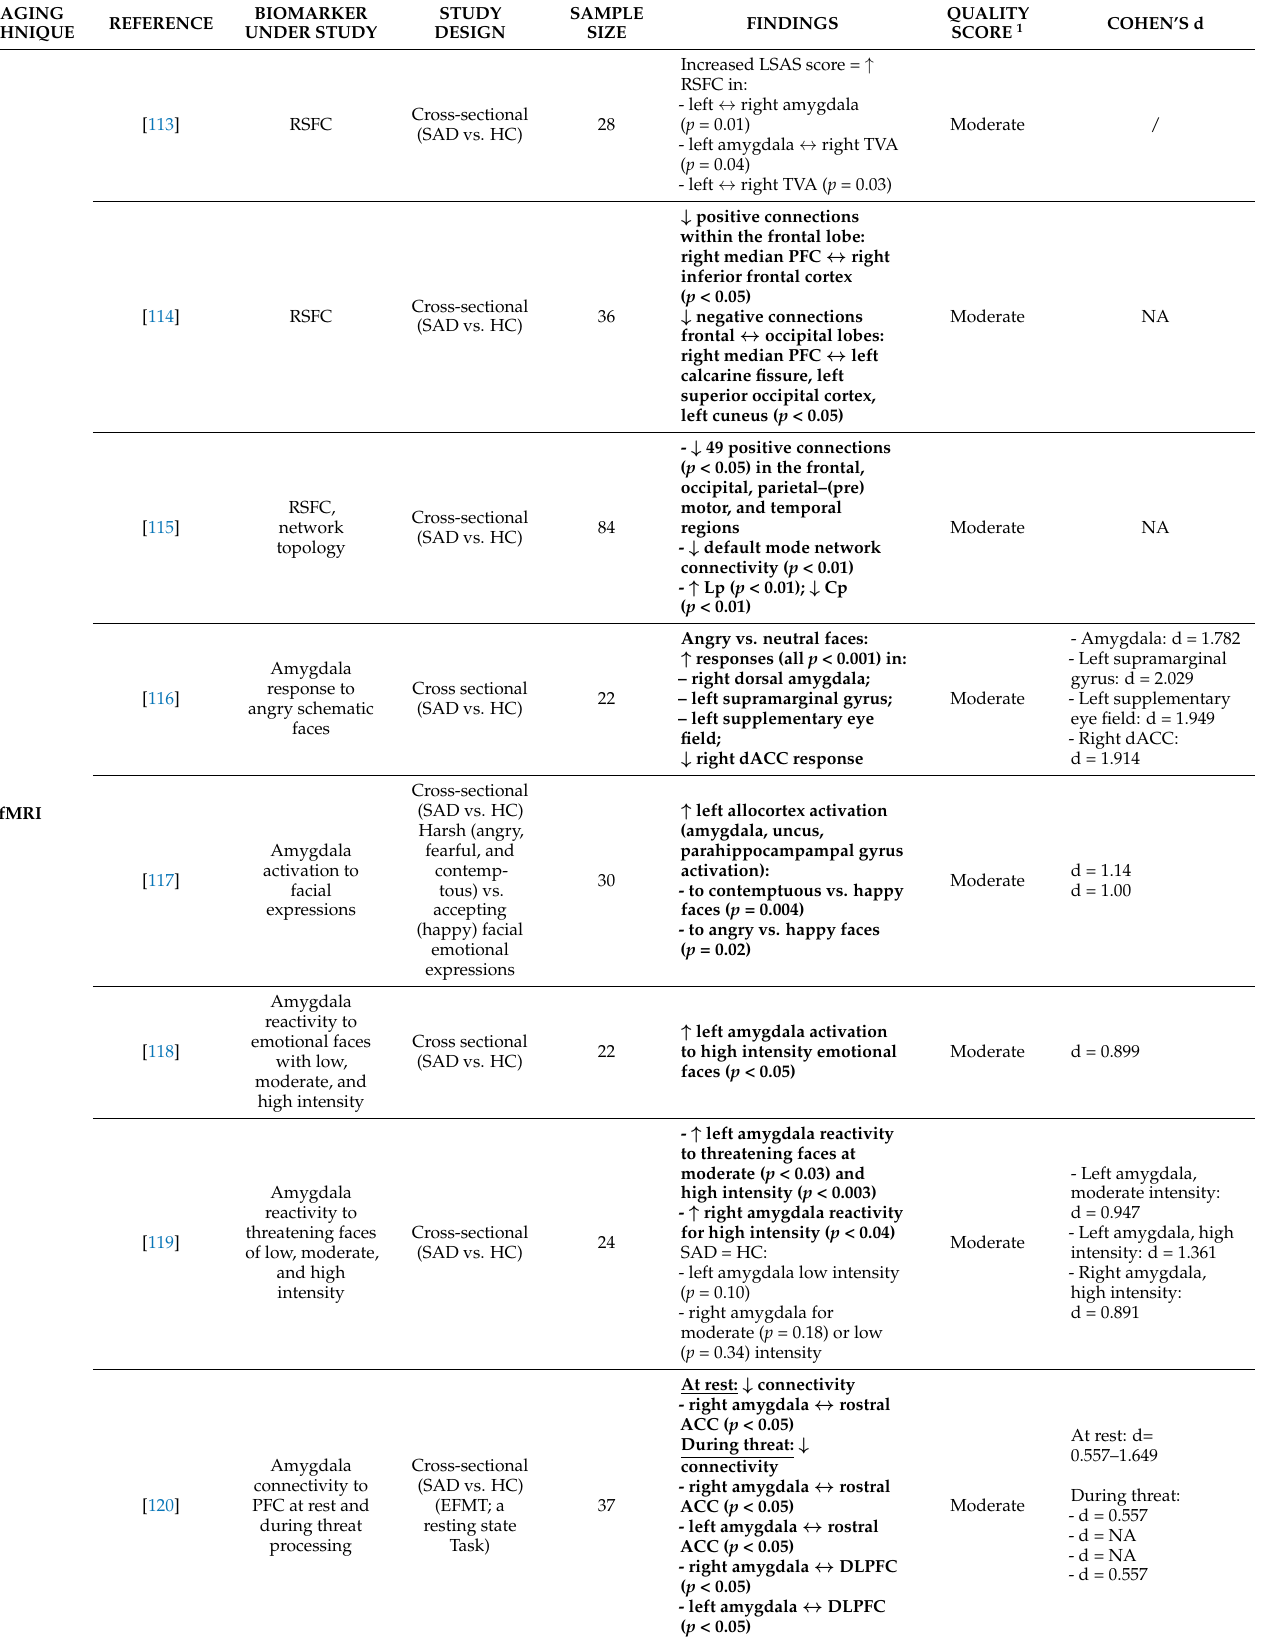
Table 6. Summary of findings regarding neuroimaging biomarkers of